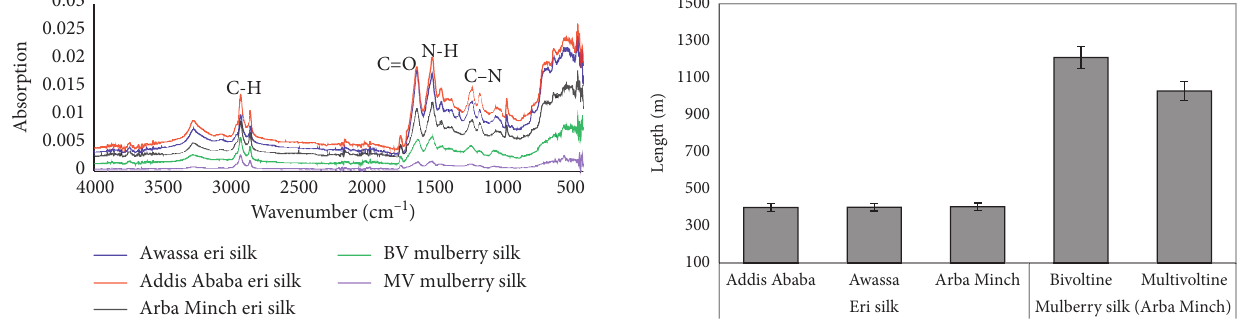
Figure 2: FTIR spectrum of bivoltine and multivoltine mulberry silks.